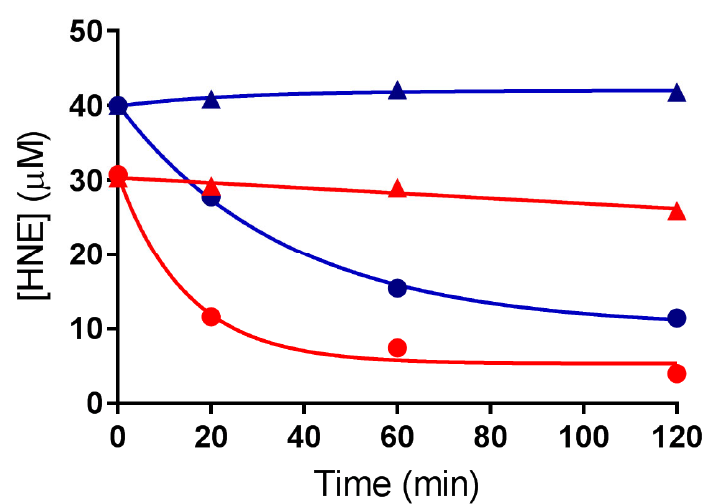
Figure 7. Removal of HNE from culture medium in the presence of HLE cells. HLE cells were grown as described in Section 2.2 and incubated in MEM in the presence of the following HNE concentrations: 30 µ M, red symbols; 40 µ M, blue symbols. Red and blue triangles refer to 30 µ M and 40 µ M HNE incubated in culture medium in the absence of HLE cells, respectively. HNE was evaluated as described in Section 2.9. Each value is the mean ± SD of three measurements, deriving from at least two independent experiments.